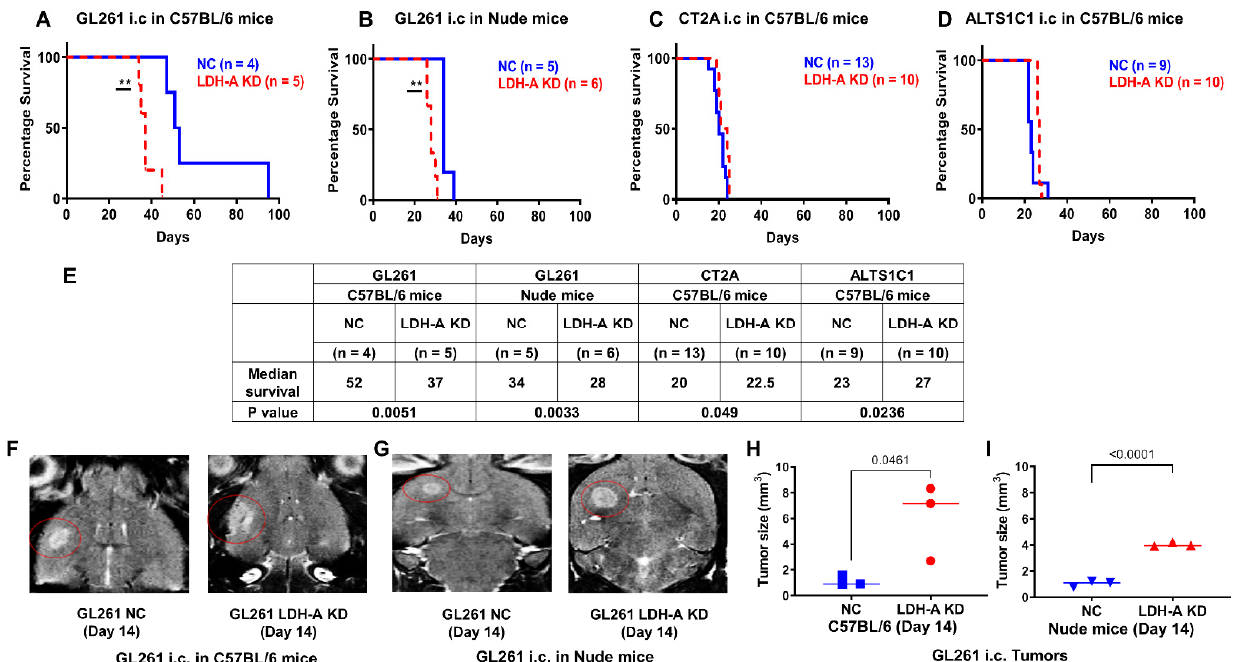
Figure 1. Survival and MR imaging of mice bearing i.c. murine gliomas. Kaplan–Meier survival plots of mice bearing i.c. GL261 ( A , B ), CT2A ( C ) or ALTS1C1 ( D ) LDH-A KD and control NC tumors; significant differences are indicated by ** p < 0.01. Median survival and comparisons between LDH-A KD and NC tumors ( E ). Representative T2-weighted MR images of i.c. GL261 NC and GL261 LDH-A KD tumors in C57BL/6 mice ( F ) and nude mice ( G ). GL261 tumor volume was estimated on indicated days, using 3-D measurements of the T2-weighted tumor signal in the images; Mean, ±SEM, n = 3 ( H , I ).